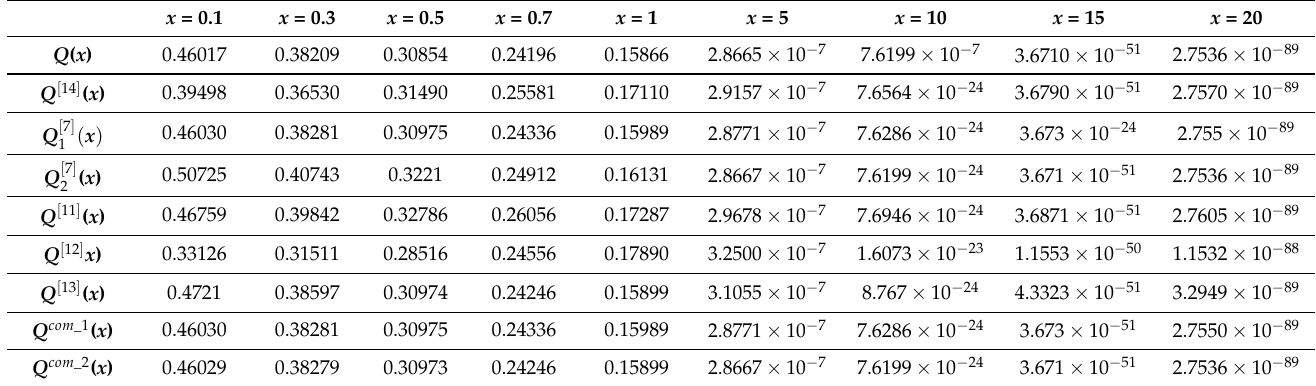
Figure 1. Comparison of several Q -function approximations. Table 2. Comparison of several Q -function approximations for discrete values of argument x